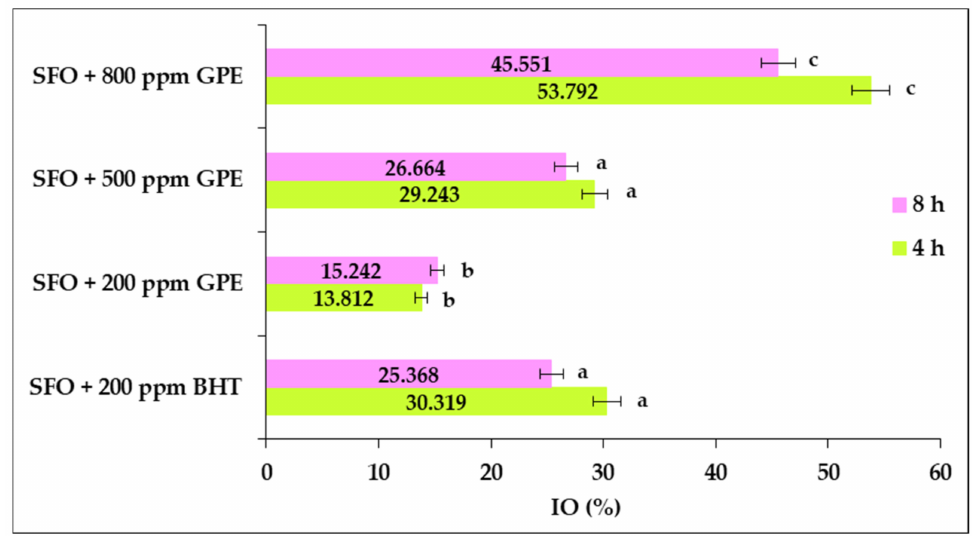
Figure 2. Changes in the inhibition of sunflower oil (SFO) oxidation during convective heat expo- sure, in response to GPE and BHT supplementation. The values for bars with different letters are significantly different from each other (one-way ANOVA, p < 0.05).